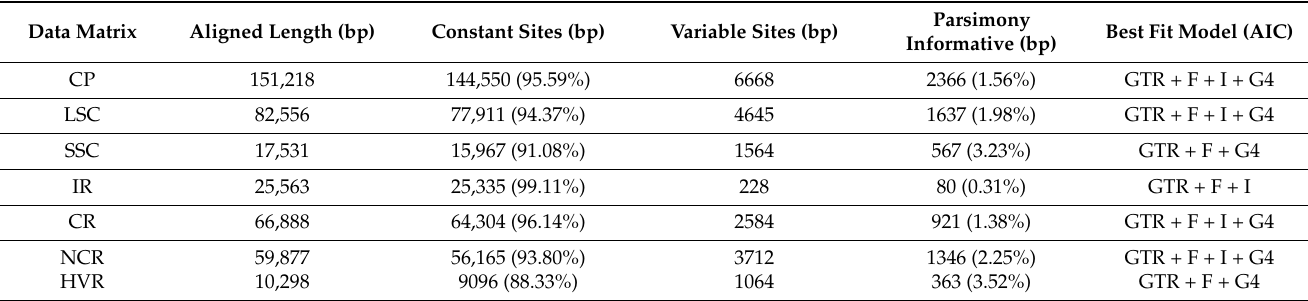
Table 2. Summary of the data set information for phylogenetic